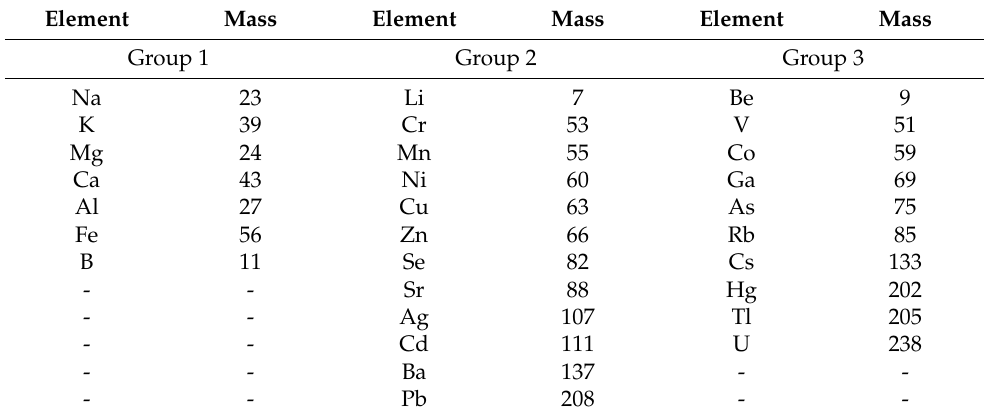
Table 2. Isotopes used in the ICP-MS analysis of water (peak jumping acquisition